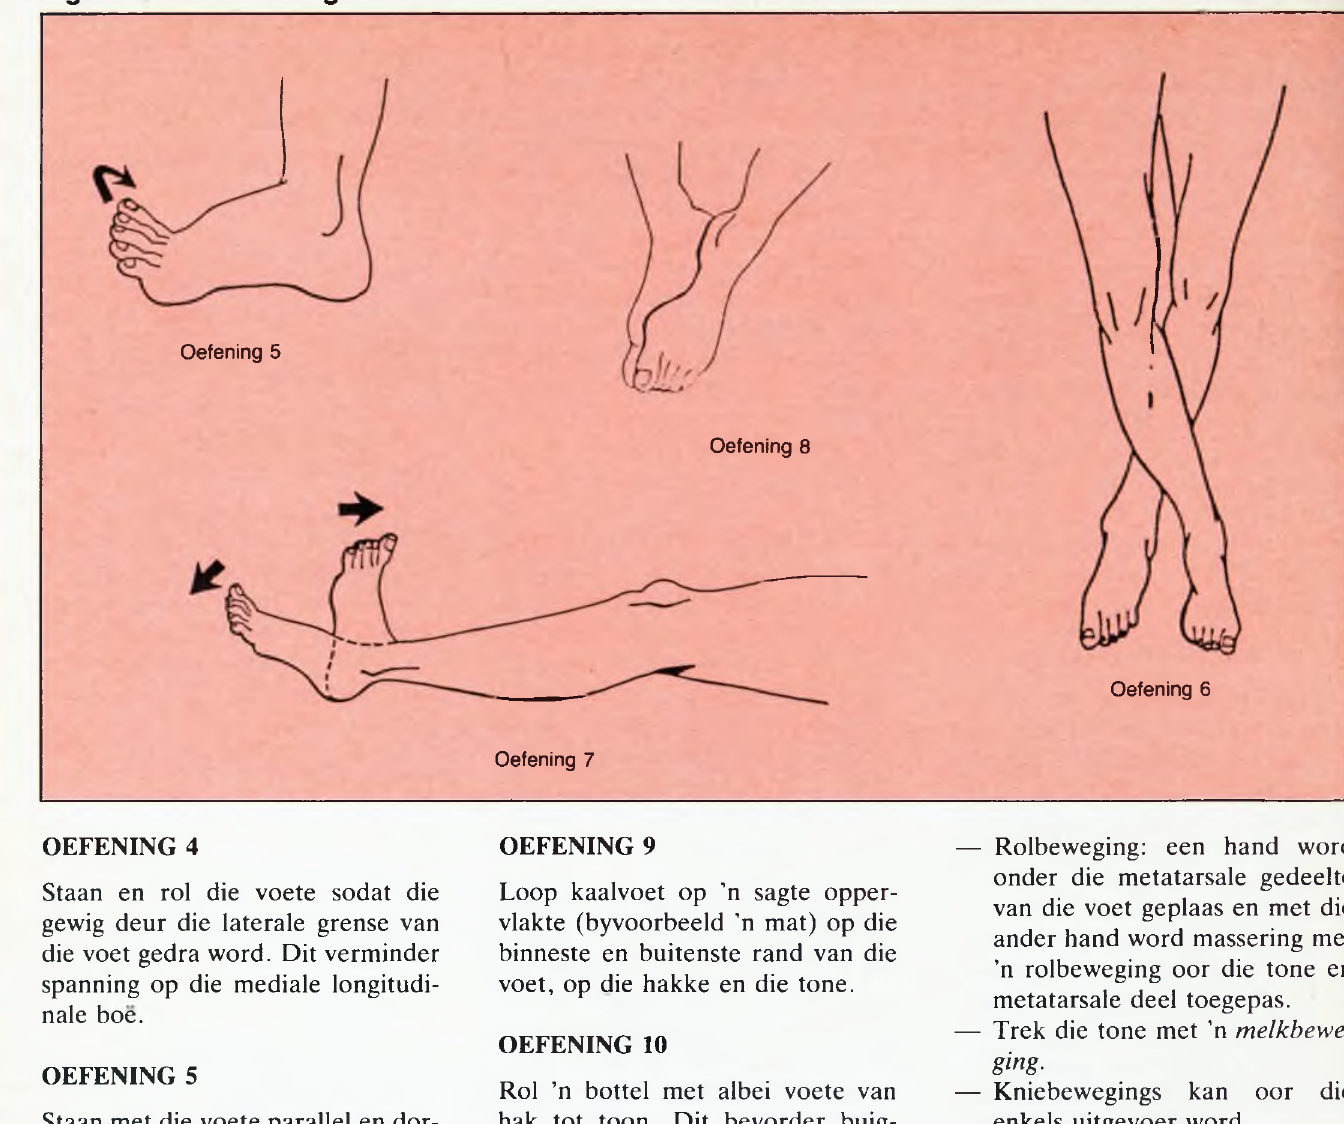
Figuur 2 Voetoefeninge